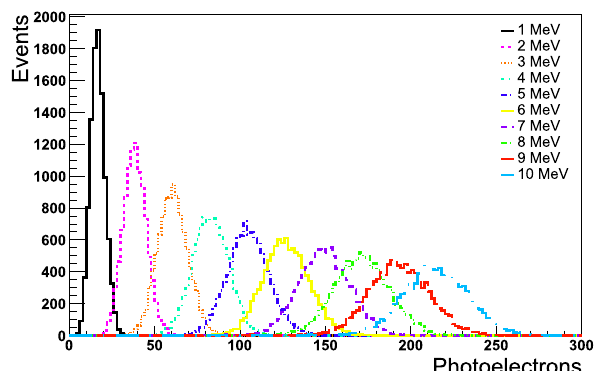
Fig. 9 Reconstructed Δ R distributionfromsimulated1MeVelectrons using the BONSAI position reconstruction algorithm